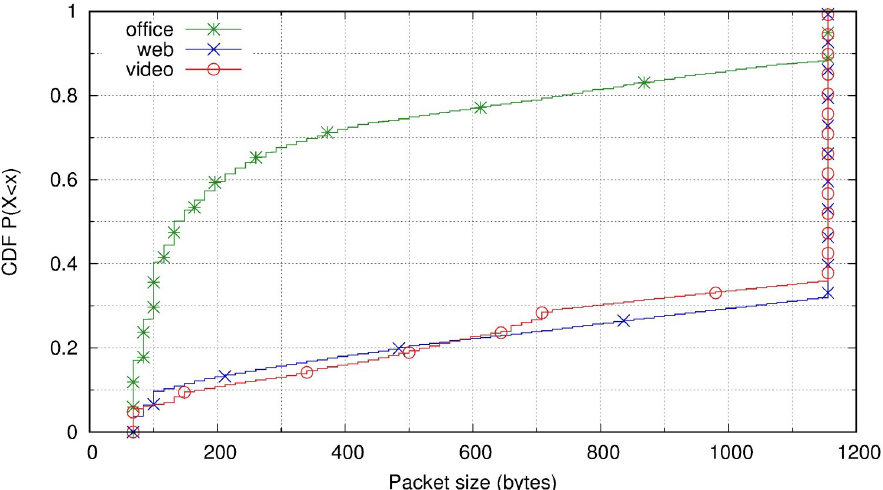
Fig 6. Packet size cumulative distribution function for three user profiles in Amazon